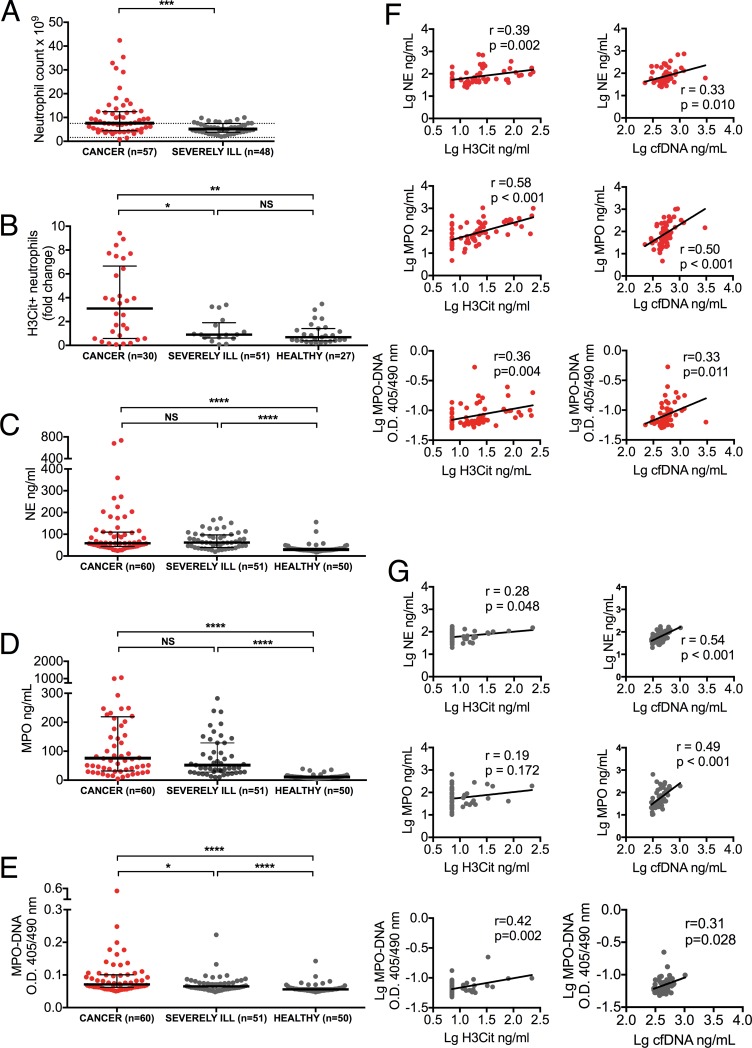
Cancer-associated neutrophil activation correlates with circulating H3Cit and cfDNA.(A) Peripheral neutrophil count was higher in cancer patients compared to severely ill patients without known cancer (dotted line represents upper reference interval). (B) Flow cytometry analysis showed a higher number of neutrophils positive for intracellular H3Cit in cancer patients compared to both healthy individuals and severely ill patients without known cancer. No significant difference was observed between severely ill patients without known cancer and healthy individuals. (C-D) Plasma NE (C) and MPO (D) were equally elevated in cancer patients and severely ill patients without known cancer compared to healthy individuals. (E) Plasma MPO-DNA complexes were significantly higher in cancer patients compared to both healthy individuals and severely ill patients without known cancer. The levels were also significantly higher in severely ill patients without known cancer compared to healthy individuals. (F) H3Cit and cfDNA correlated positively with NE, MPO and MPO-DNA complexes in cancer patients. (G) Similar correlations were seen in severely ill patients without known cancer, with the exception of correlations between H3Cit and NE and MPO. Lines represent medians with IQR. Groups were compared with the Mann-Whitney U test. Significance of correlation was analyzed with Pearson correlation coefficient after log transformed data to obtain a normal distribution. NS P > 0.05, * P < 0.05, ** P < 0.01, *** P < 0.001, **** P < 0.0001.